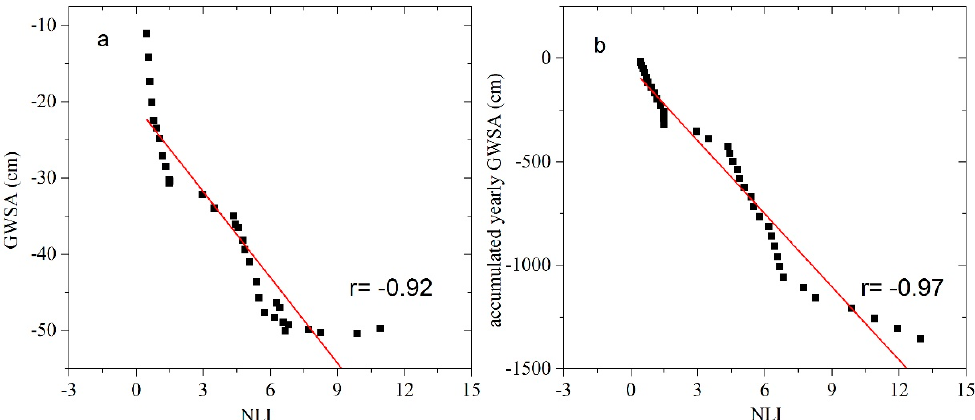
Figure 8. The relationship between night light index (NLI) and GWSA as evaluated by the Pearson correlation coefficient at the 5% level. ( a ) the relationship between NLI and GWSA (r = − 0.92, p < 0.01); ( b ) the relationship between NLI and accumulated yearly GWSA (r = − 0.97, p < 0.01).